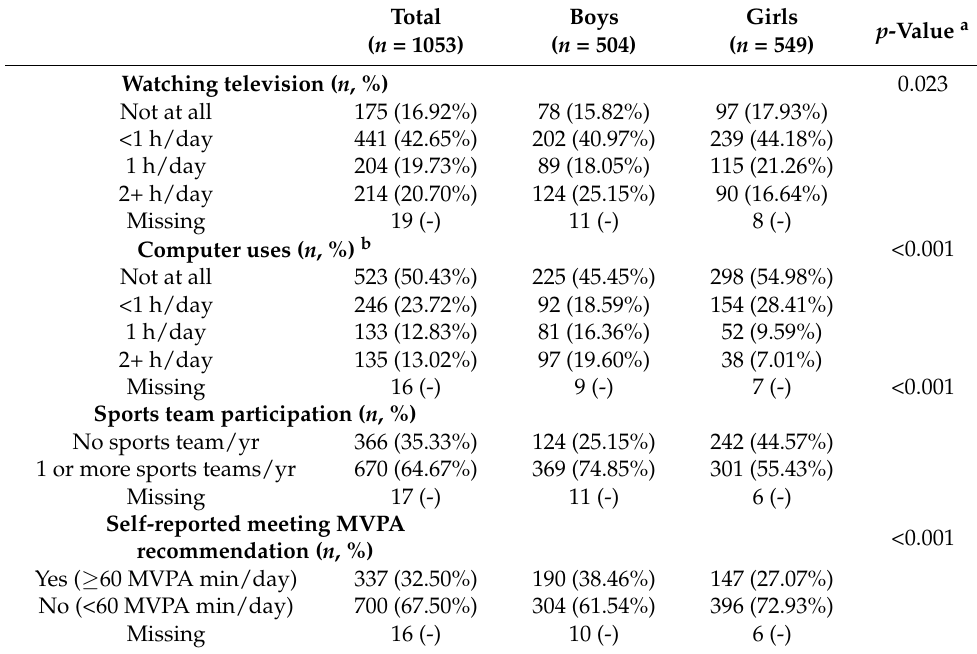
Table 4. Self-reported physical activity pursuits and sedentary behaviors.